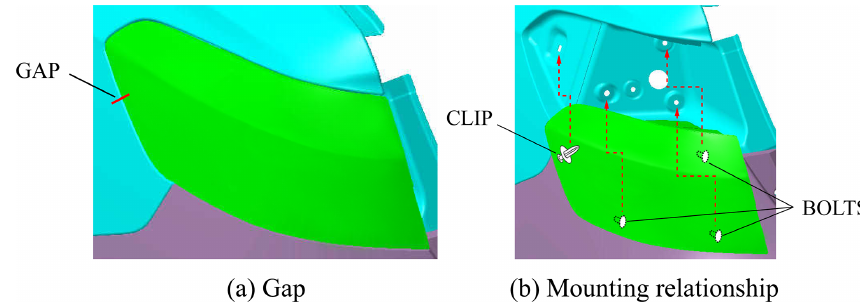
Figure 6. The gap and the mounting relationship between the taillight and bodyside